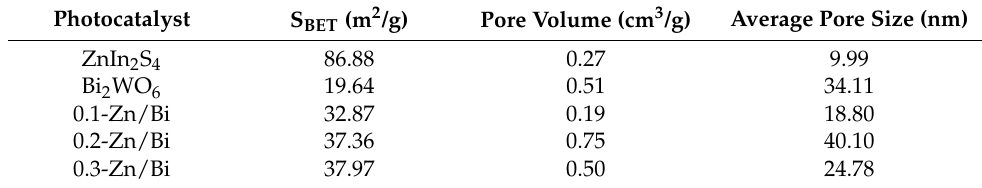
Table 1. The specific surface area and pore size distribution of as-prepared